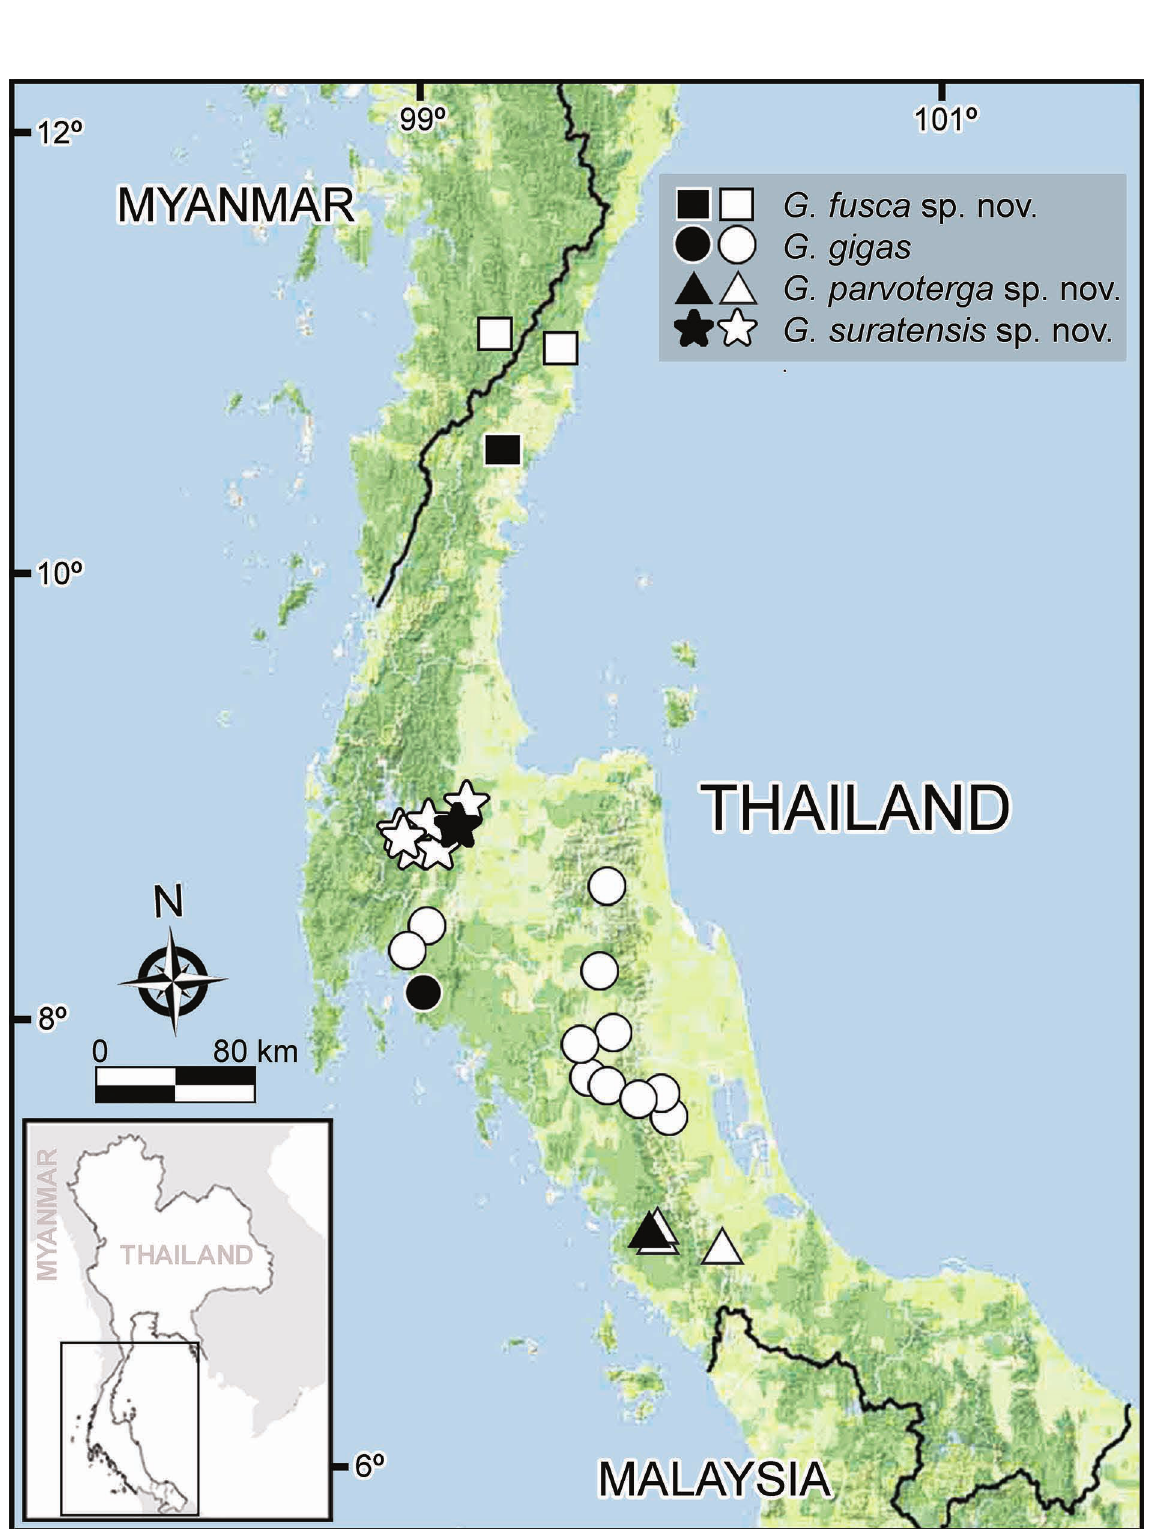
Fig. 24. Known distribution of all Gigaxytes gen. nov. species (black symbol = type locality, white symbol = other